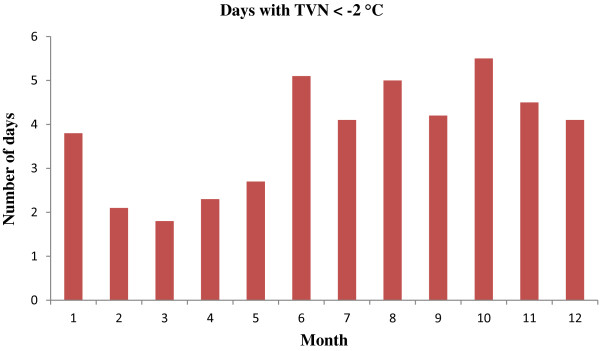
Monthly average number of days with TCN < -2°C.